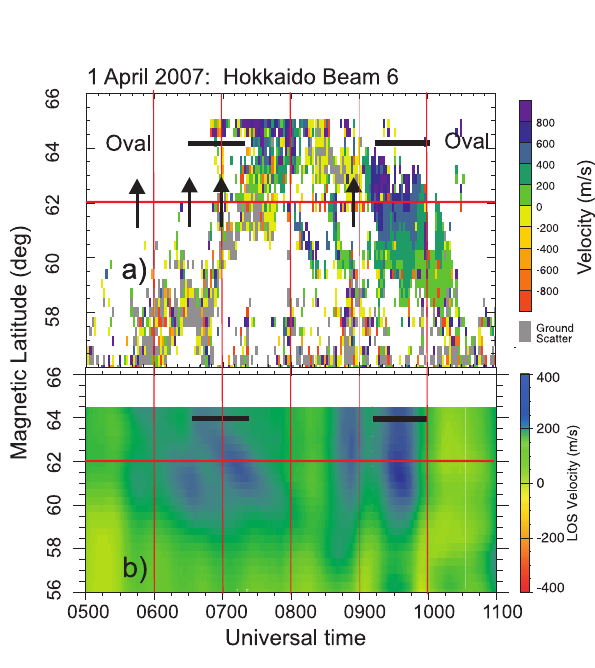
Fig. 6. (a) The Hokkaido radar velocity in beam 6 versus time for the 1 April 2007 event (the same plot as in Fig. 3a) and (b) predicted velocity according to the Comprehensive Ring Current model. No- tice the difference in the velocity scale for observations and model- ing. Horizontal line 3 =62 ◦ is given to facilitate the intercompari- son. Also marked are the estimated latitude of the Feldstein-Starkov auroral oval (Feldstein and Starkov, 1967) and the moments for the substorm